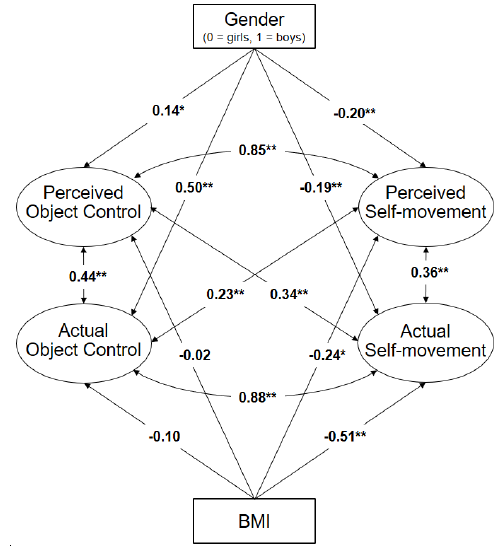
Figure 3. Confirmatory factor analysis with the covariate gender (model 4). * Significant di ff erences at the level of p ≤ 0.05; ** Significant di ff erences at the level of p ≤